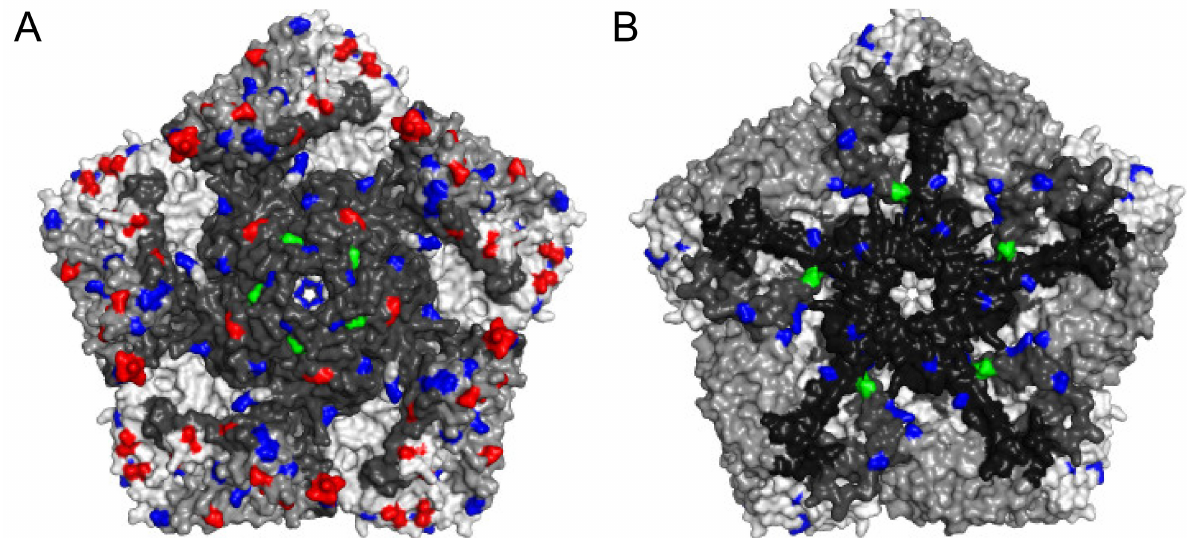
Figure 4. The locations of amino acid substitutions in selected iVDPV2 isolates. The three-dimensional structure of type 2 wild poliovirus strain MEF-1 was obtained from PDB 1EAH and represented as a pentameric unit (( A ): outside; ( B ): inside of capsid). Each protomer contains a single copy of VP1, VP2, VP3, and VP4 distinguished by gray colors. The location of frequent amino acid substitutions (more than 4 out of 19 iVDPV2 isolates) relative to the Sabin 2 strain is colored. The neutralizing antigenic sites are red. The hypervariable residues and the gatekeeper substitution of VP1-143 are green. Other amino acid changes are blue. The image was generated using PyMOL 2.4.2